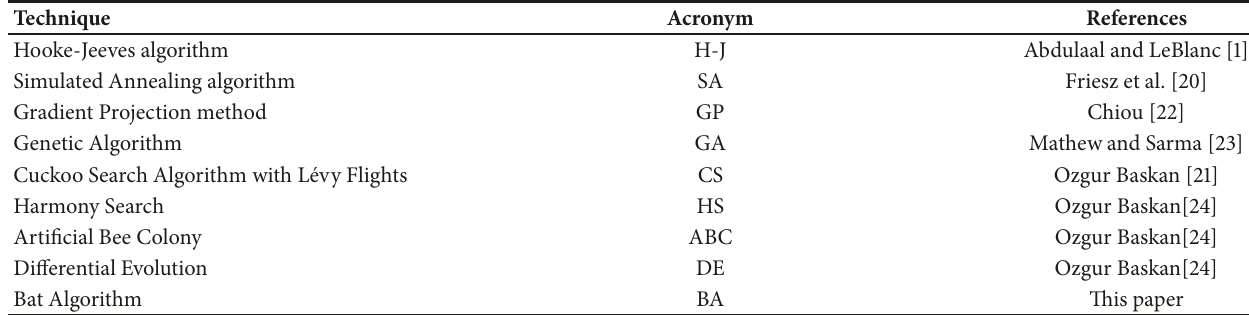
Table 6: Techniques and references of test case